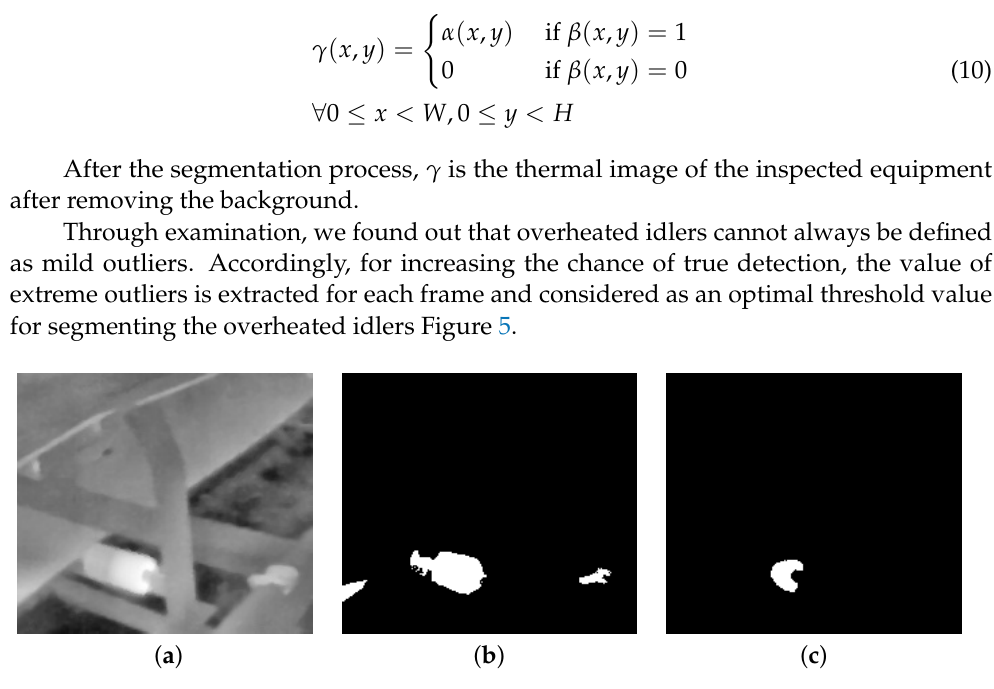
Figure 5. Comparison of extreme and mild outliers in segmentation of an overheated idlers. ( a ) Pre- processed ROI before segmentation, ( b ) Segmentation results of mild outliers detection, ( c ) Segmenta- tion results of extreme otliers